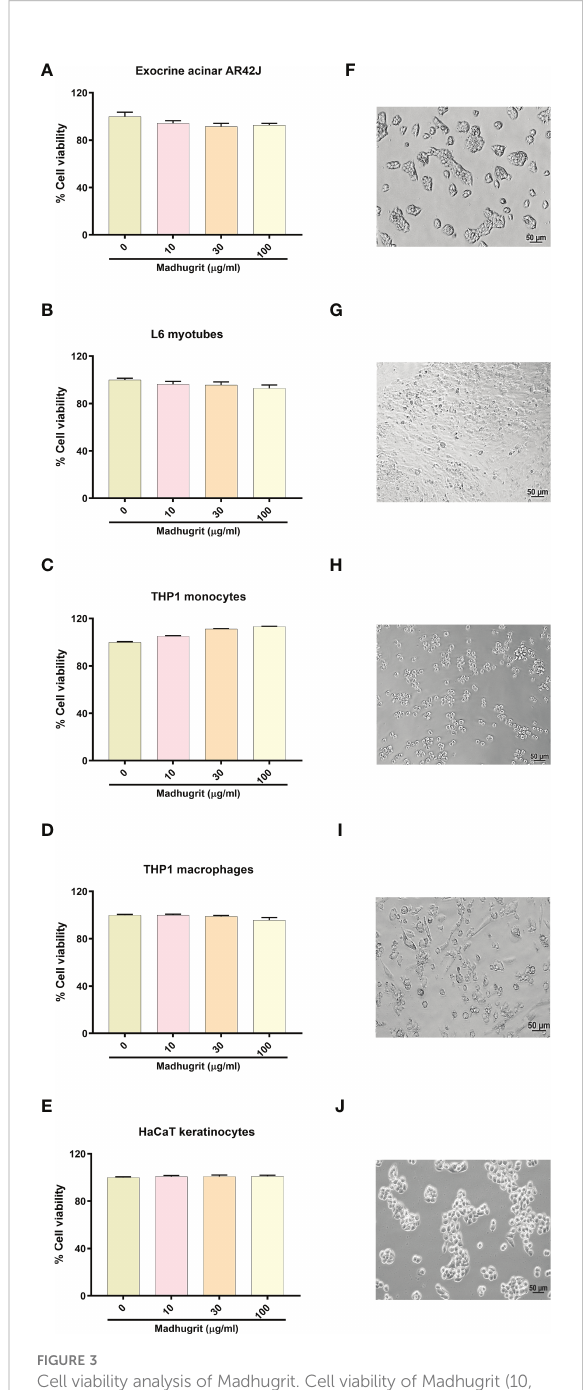
FIGURE 3 Cell viability analysis of Madhugrit. Cell viability of Madhugrit (10, 30, and 100 µg/ml) was performed on Exocrine acinar AR42J cells (A) , L6 myotubes (B) , THP1 monocytes (C) , THP1 macrophages (D) and HaCaT keratinocytes (E) by Alamar blue assay. Corresponding representative images of the cell lines used for the analysis (F-J)